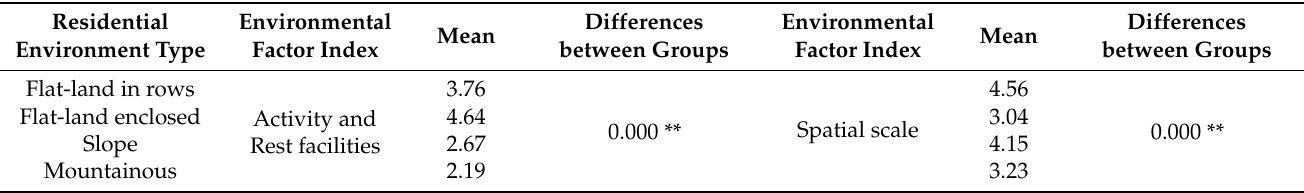
Table 6. Comparison of Environmental quality assessment among different types of residential environments.